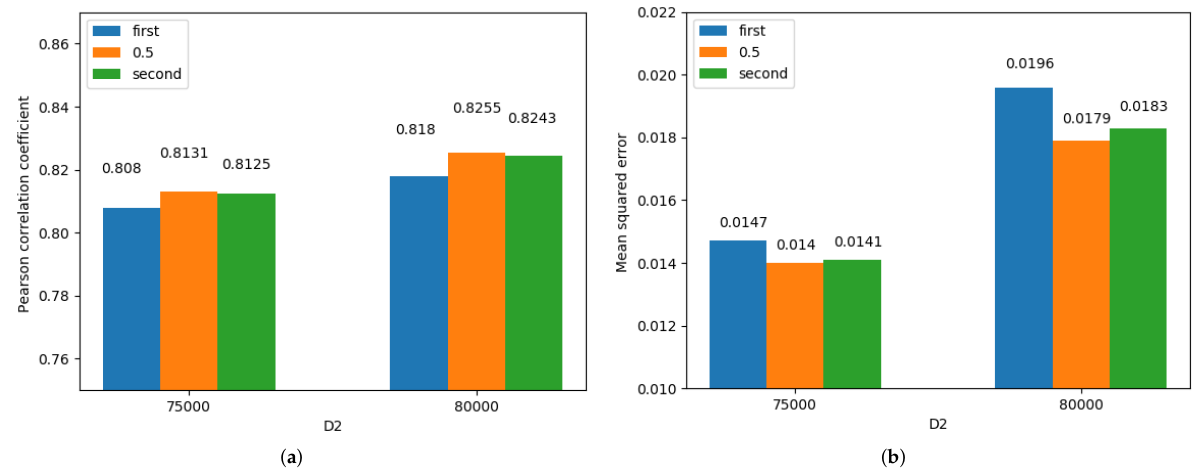
Figure 3. Detailed influence of t i , j on STS’12.OnWN. ( a ) Pearson correlation coefficient, ( b ) Mean squred